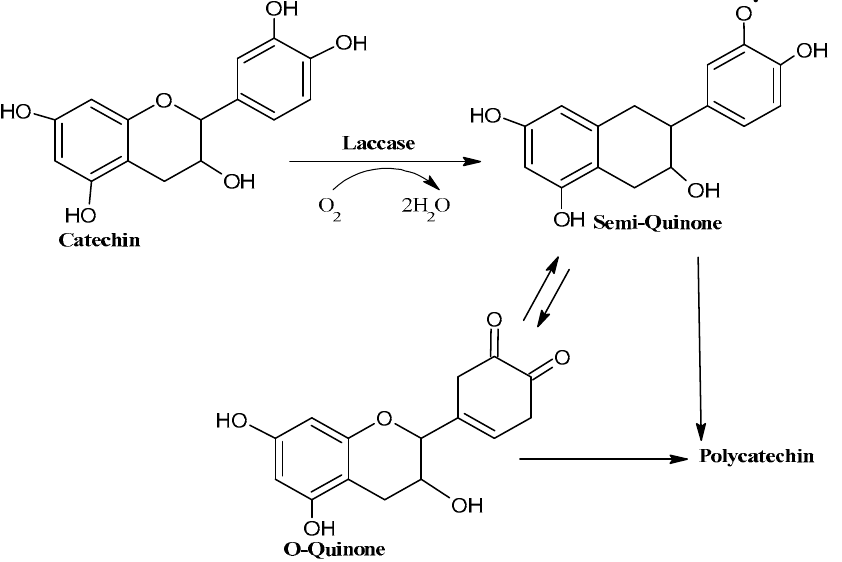
Figure 5. Mechanism of catechin oxidation by laccase where catechin is polymerized into polycatechin with the intermediate formation of semiquinone radicals and orthoquinone.